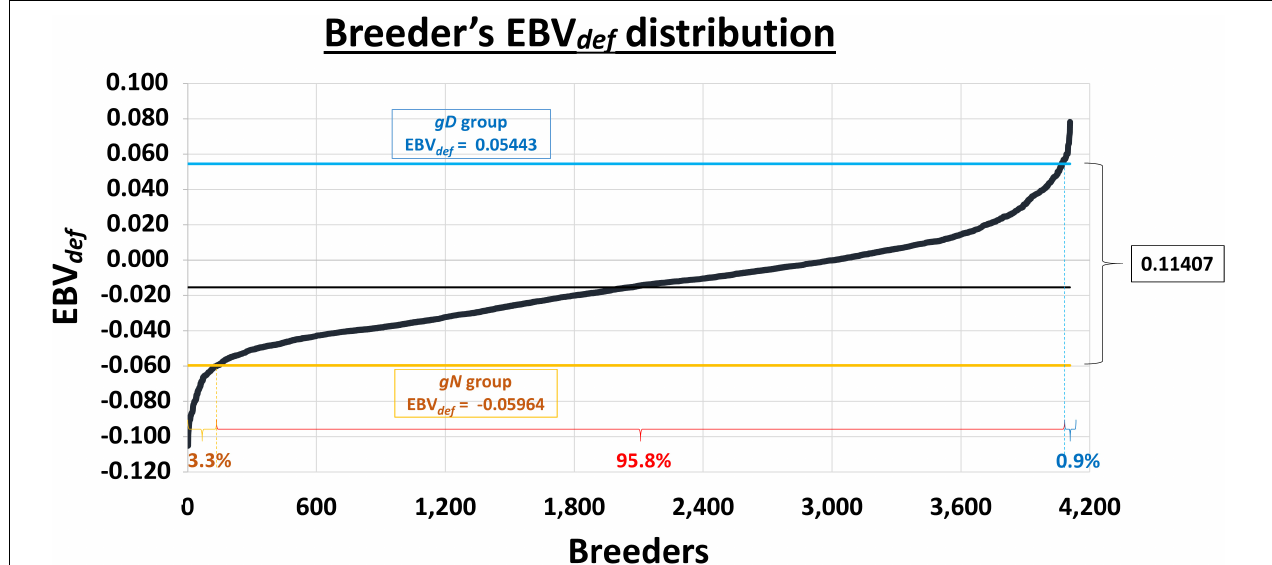
FIGURE 1 | The distribution of 4,108 breeders from the 3 rd generation of the Spanish National Breeding Program (PROGENSA R (cid:13) ) according to their estimated breeding value for the presence or absence of deformity at commercial size (EBV def ). In yellow is the mean EBV def of the genetically normal ( gN) preselected breeders and the percentage of breeders with a lower value. In blue is the mean EBV def of the genetically deformed ( gD) preselected breeders and the percentage of breeders with a higher value. In red is the percentage of breeders with intermediate EBV def .